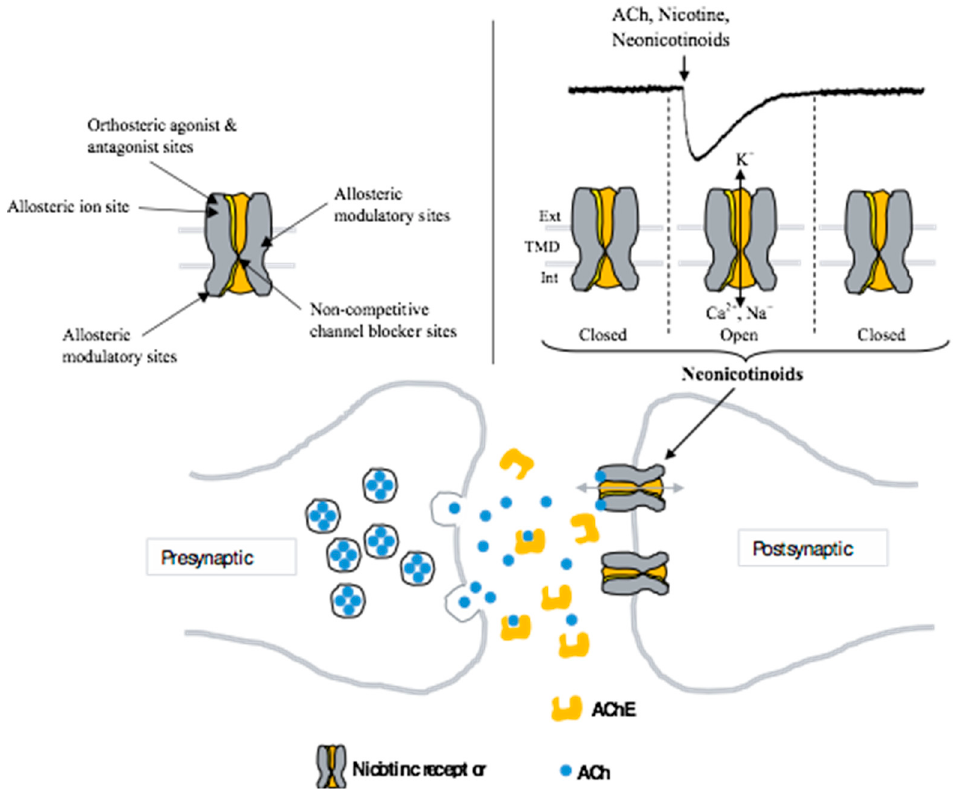
Figure 1. Representation of the cholinergic synapse and ion channel selectivity. The neuronal nicotinic acetylcholine receptors (nAChRs) are located at the postsynaptic terminal. Agonist, antagonist, non- competitive channel blocker, and allosteric sites are represented in the cut-away view showing four of the five subunits forming the pentameric receptor-channel complex. Ext: Extracellular; TMD: transmembrane domain; Int: intracellular.